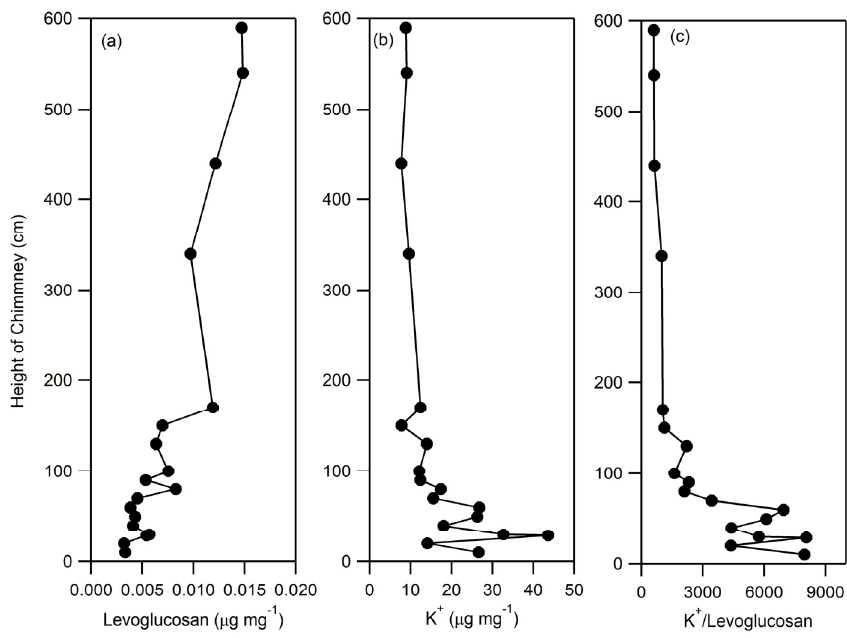
Figure 4. Vertical profiles of the concentrations ( µ g mg − 1 ) of ( a ) levoglucosan and ( b ) K + in the chimney deposits and ( c ) mass concentration ratios of K + /levoglucosan.